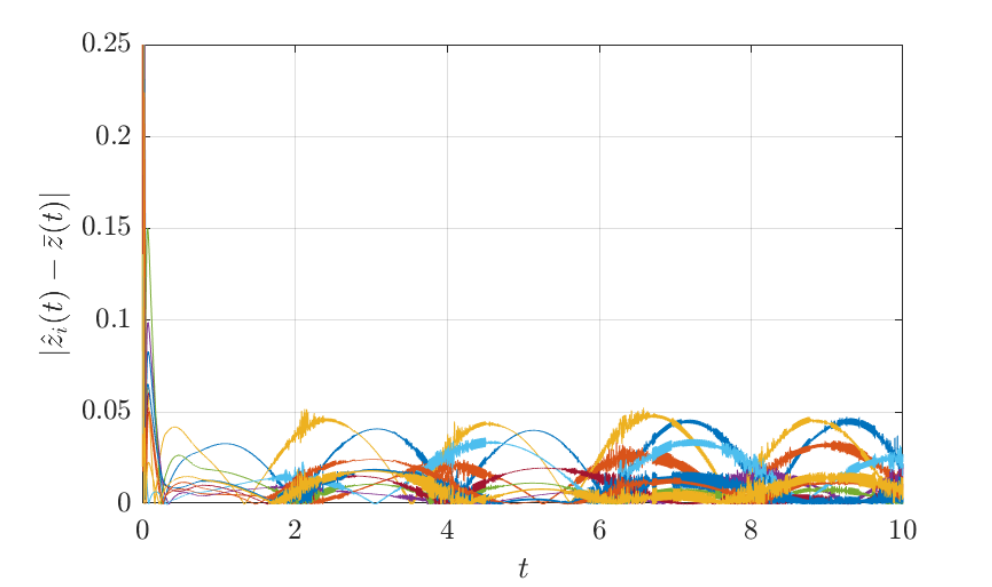
Figure 6. Consensus error for our protocol with ∆ = 10 − 3 , ε = 0.01. Compared to the case shown in Figure 4, with ∆ = 10 − 4 , the consensus error has